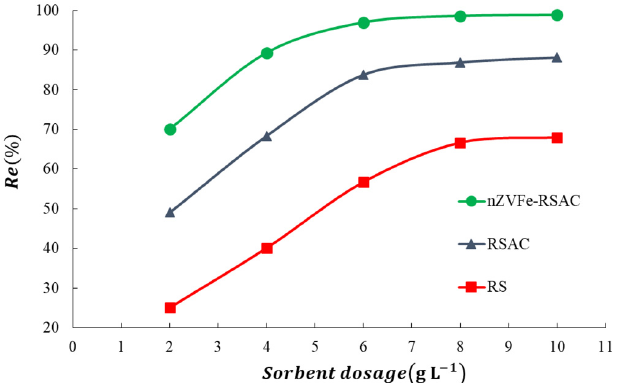
Figure 6. Effect of sorbent dosage on the Pb(II) adsorption by RS, RSAC, and nZVFe–RSAC .